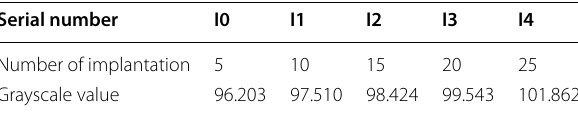
Table 2 Statistics of hairy gray value of Z -yarn samples under different implantation